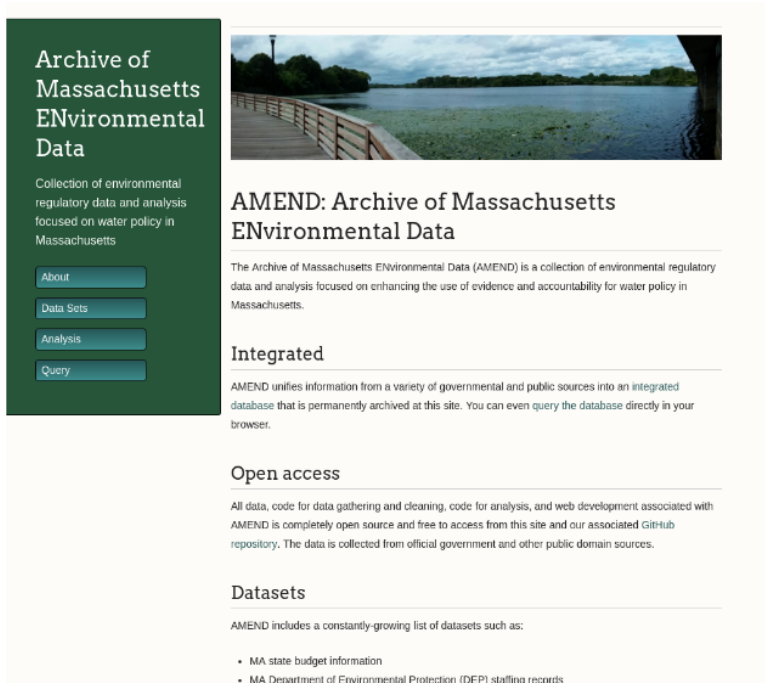
Figure 1. Screenshot of the AMEND website front